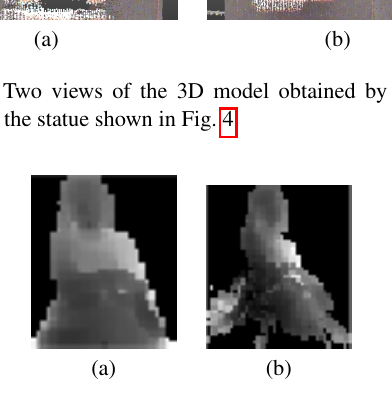
Figure 10. Comparison between depth computed from the ref- erence model (a) and the one derived from smartphone stereo- vision 3D model (b) for the artwork shown in Fig.